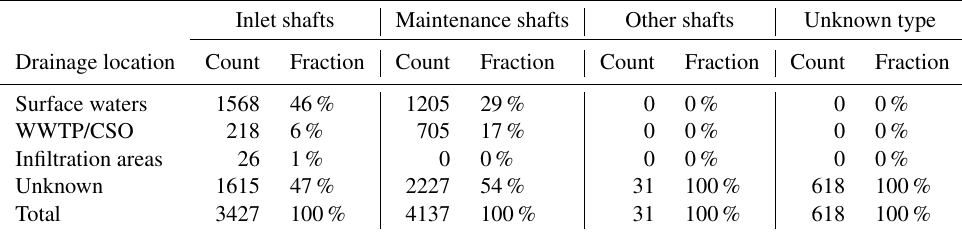
Table 3. Number of shafts found in agricultural areas of the study areas per shortcut category and drainage location. WWTP – wastewater treatment plant; CSO – combined sewer overflow.